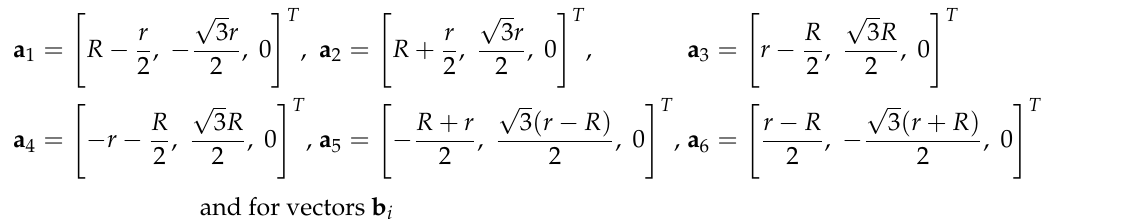
Figure 5. Top view of the CDPR under exam at a reference position. The components of vectors a i